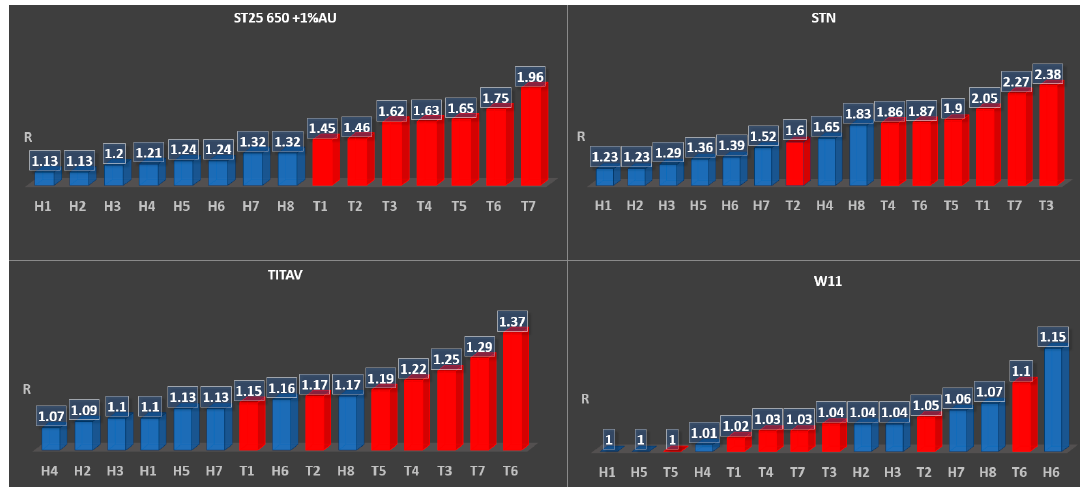
Figure 4. Test results from ST25 650+Au, STN, TiTaV, and W11 on multiple blood samples.